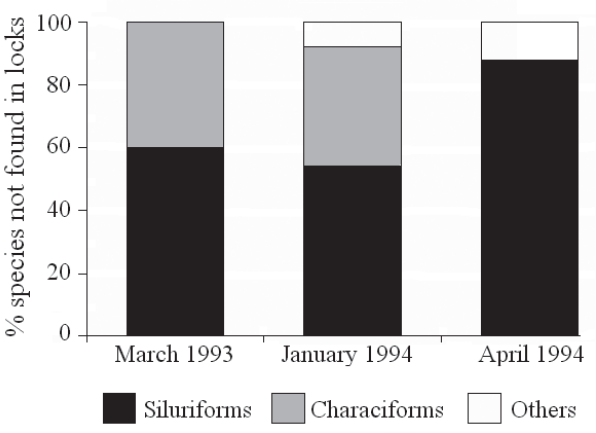
Fig. 7. Proportion of species grouped by order that were sampled in the tailrace and never sampled in the Borland locks of Salto Grande